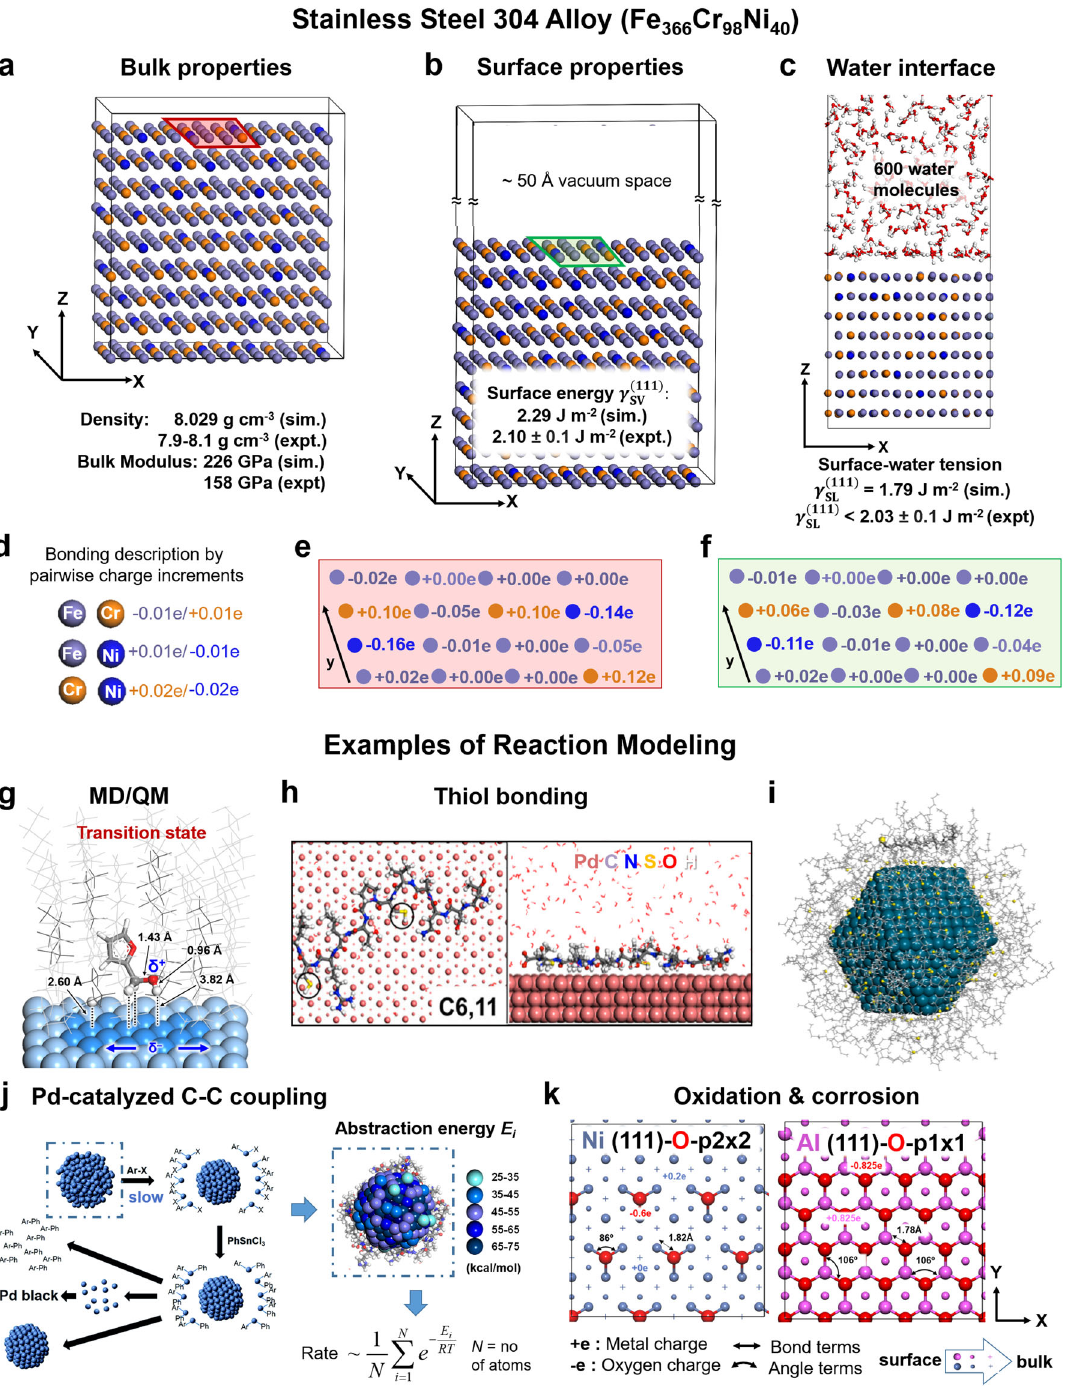
Fig. 4 Application of the LJ parameters for the simulation of stainless steel and chemical reactions. a – c Models of type 304 stainless steel (fcc Fe – Cr – Ni with 18 wt% Cr and 8 wt% Ni) and computed bulk properties. Density 88 , surface energy 60,62 , and liquid interfacial properties agree very well with experimental data. The bulk modulus 89 is overestimated (using 12-6 LJ parameters). d – f Charge increments represent charge transfer between nearest-neighbor atoms 31 . Atomic charges are a function of the coordination number and differ for bulk atoms (highlighted atoms in a are shown in e ) versus surface atoms (highlighted atoms in b are shown in f ). The magnitude of pairwise charge increments depends on differences in atomization energy, ionization energy, and electron af fi nity. g MD/QM combinations to analyze local reactions 80 . The QM region is shown in a darker color. h , i Covalently bound thiols to metal surfaces and nanoparticles can be represented by an increased LJ well depth for the sulfur atoms 91 . j Prediction of reaction rates of differently shaped Pd nanoparticles in C-C Stille coupling using knowledge about the rate-determining step and classical simulation 24,25 . k Representation of chemisorbed oxygen on aluminum and nickel surfaces using added bonded parameters based on experimental data 92 – 95